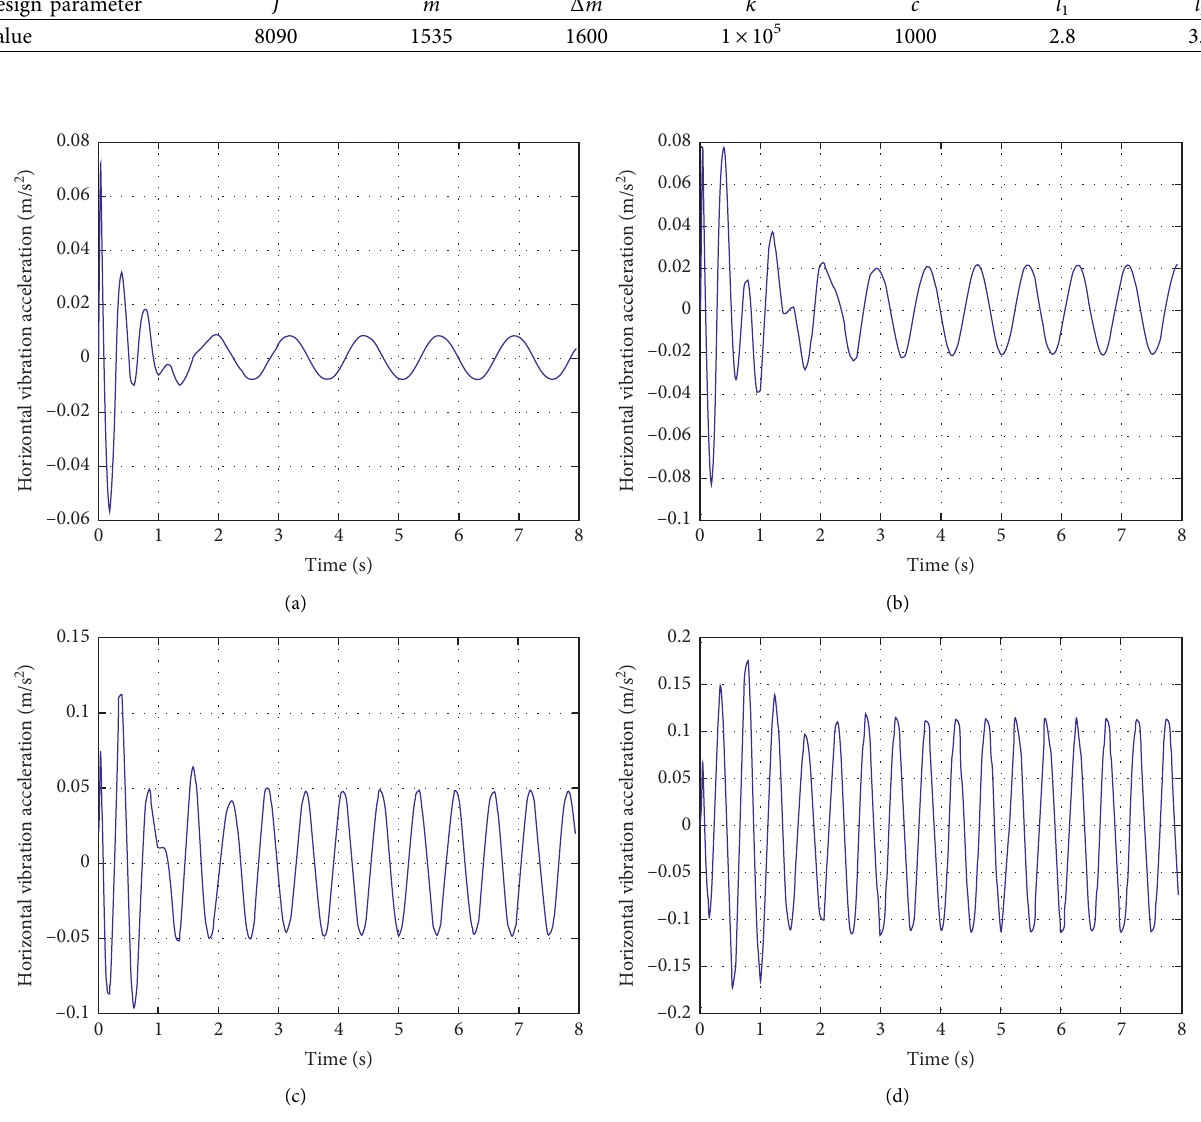
Figure 4: Influence of lifting speed on elevator horizontal vibration. (a) v � 1 m/s. (b) v � 3m/s. (c) v � 5 m/s. (d) v � 7m/s.